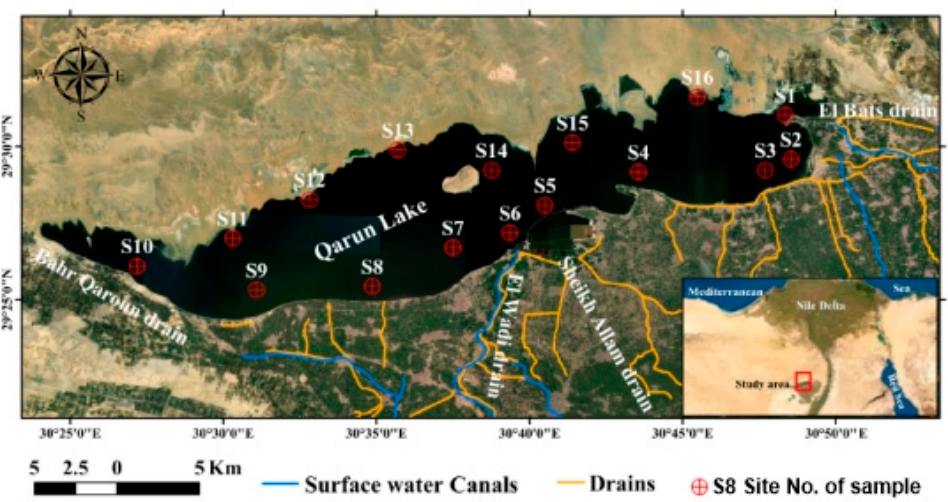
Figure 1. Location map of the study area and gauging sites. Geologically, in the Fayoum area, the stratigraphic succession extends from Qua- ternary to Tertiary. The Fayoum Depression excavate in Middle Eocene rocks, which composed of gyps-ferrous shale, white marls, limestone, and sandstone [62]. Quaternary deposits formed of eolian, Nilotic (alluvial sediments), and lacustrine deposits surround the Qaroun Lake. Sands and gravels of various sizes intercalated with calcareous silt and clay content in alluvial sediments. Claystone, gypsum, and calcareous minerals intercalated with ferruginous sandy silt in the lacustrine deposits [63]. The bottom sediments of eastern and southern sides of the Qaroun Lake composed fine fractions (less than 63 microns) of about > 70%. The organic matter in the lake bottom sediment ranged between 3 and 17, the lake water salinity varied from 28 g/L to 40 g/L, and surface temperature ranged between 22 to 25 ◦ C, while the drain water salinity was recorded to be 0.6 to 2 g/L. The sand dunes composed more than 1% of heavy minerals